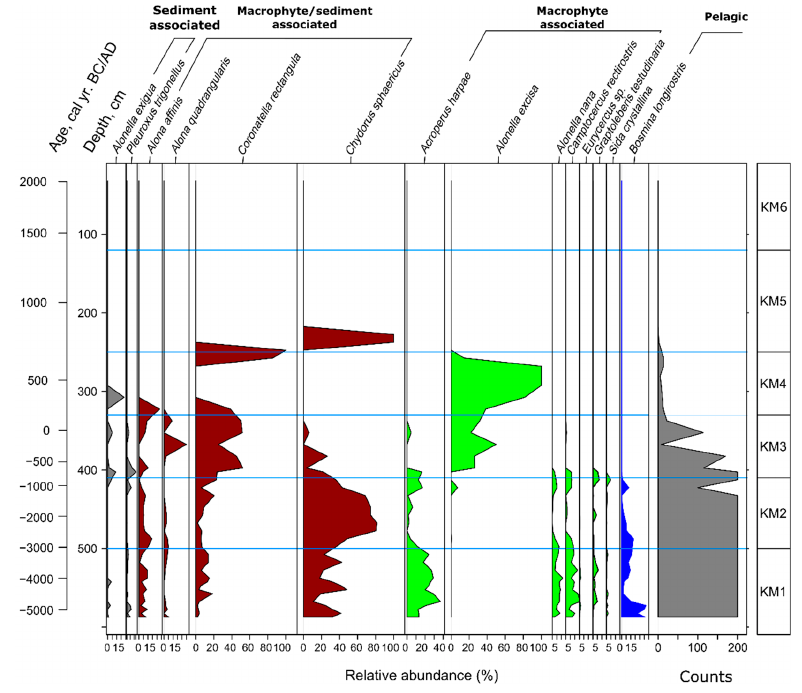
Figure 7. Cladocera composition in the deposits of the Krivetskiy Mokh mire. Blue-green color—sediment-associated Cladocera, brown color—macrophyte/sediment associated, green color—macrophyte associated, blue color—pelagic, grey color—total counts. KM1–KM6—the zones defined based on the main developmental stages of the mire.